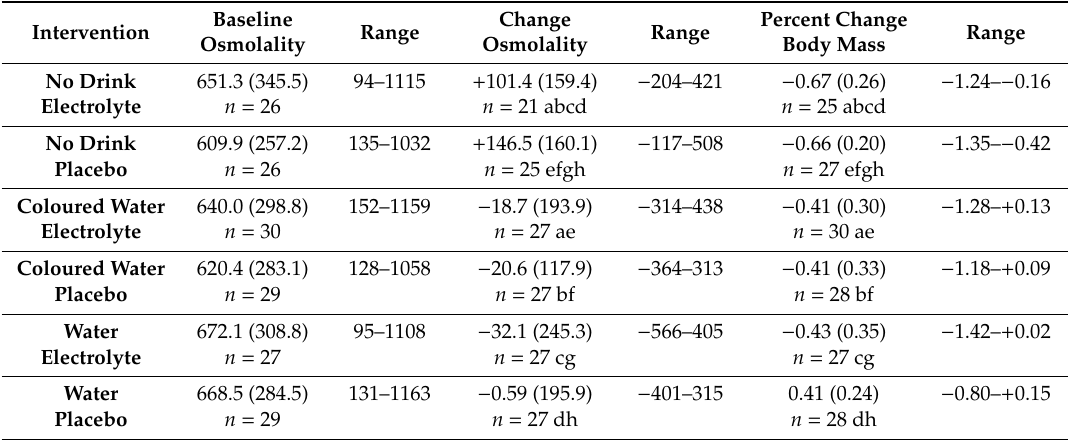
Table 1. The influence of six interventions on various indices of hydration